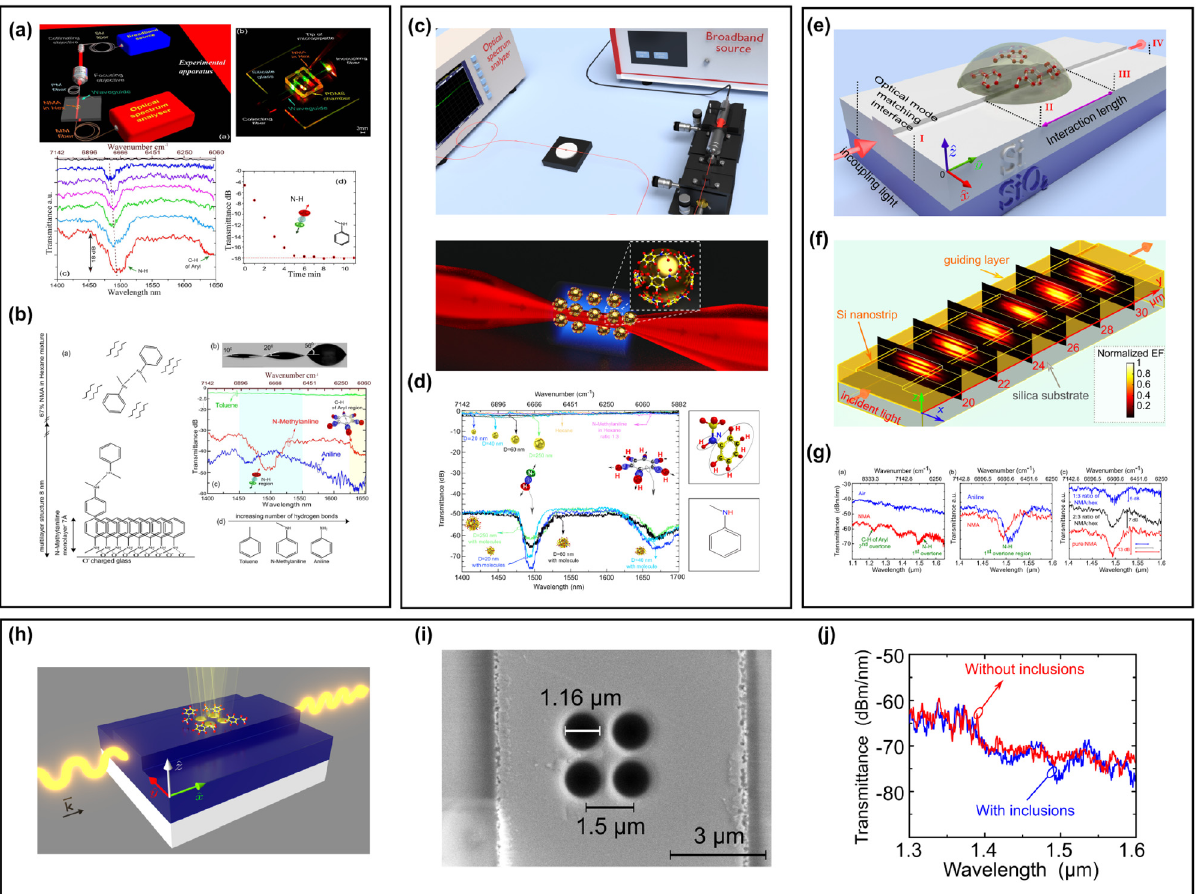
Figure5: Overtonespectroscopyusingguidedwavestructures.(a)ExperimentalapparatusandrecordedspectraofNMAmoleculesadsorbed on the waveguide. (b) Responses from benzene molecules with different substituents demonstrating the influence of hydrogen bonding ((a) and (b) are reproduced from [76]). (c) Experimental apparatus (top) and sculptured micro fi ber architecture (bottom) and (d) the experimental results on the micro fi ber and the chemical structure of NMA (reproduced from [77]). (e) Schematic of Si nanostrip rib on-chip sensor, (f) evolution of the interfered guided modes in the interaction length with the analyte and (g) Measured spectrum from Si nanostrip rib waveguide embedded in NMA molecules, aniline and different mixture ratios of N -methylaniline in hexane (reproduced from [78]). (h) Schematic of the dielectric rib waveguide with cluster of inclusions of cylindrical shape, (i) SEM image of the fabricated inclusions on the rib waveguide and (j) Measured transmittance spectra with on reference waveguide (red curve) and on waveguide with inclusions (blue curve) ((h) – (j) are reproduced from